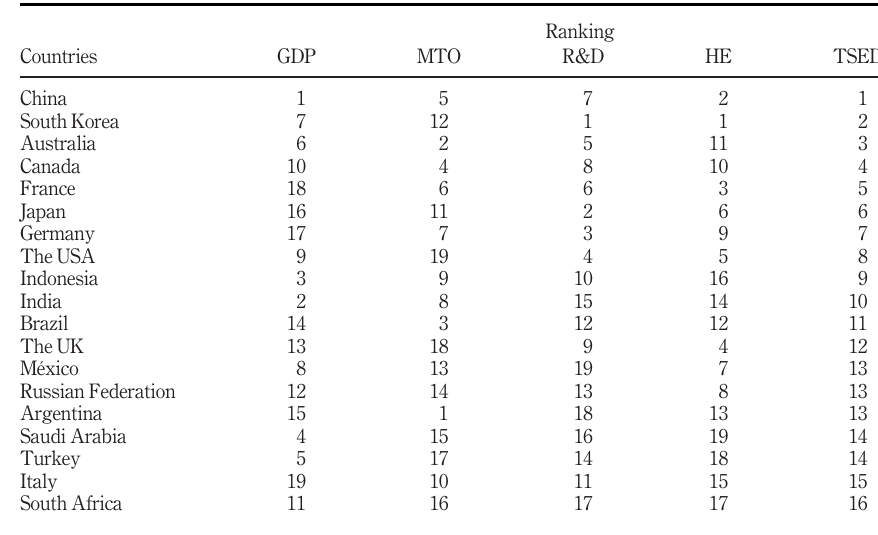
Table V. Economic development TOPSIS ranking